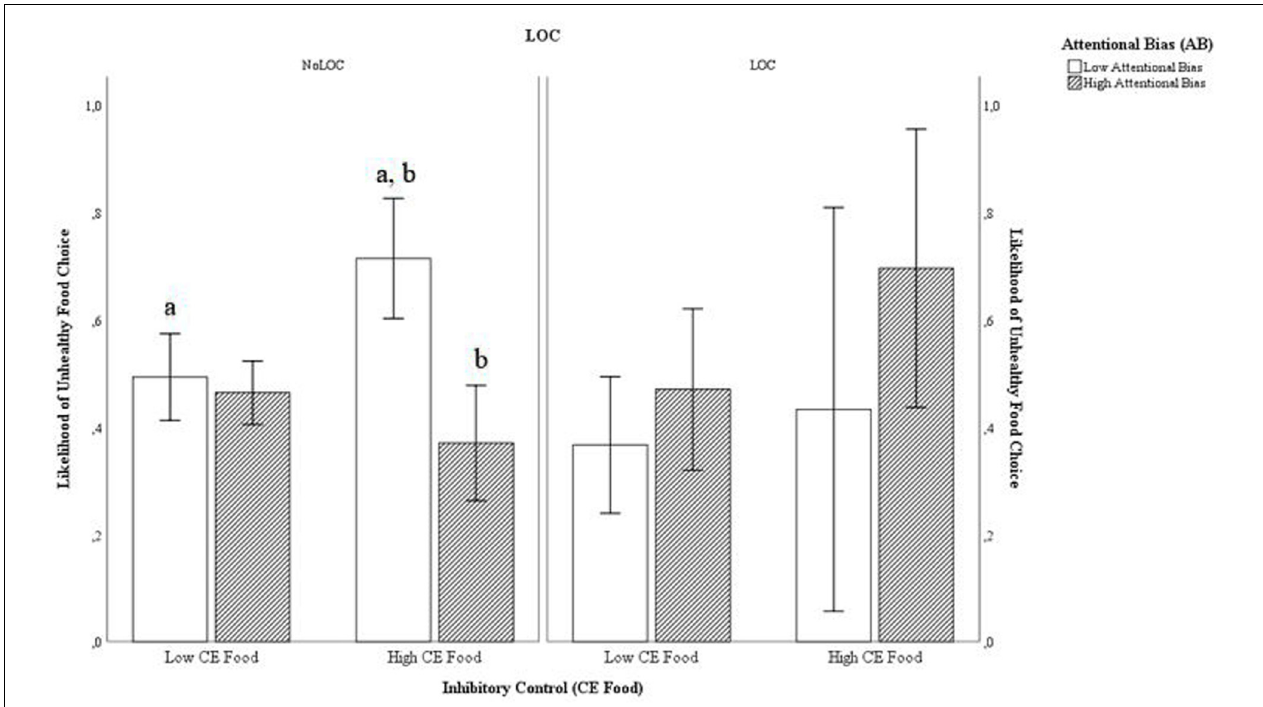
FIGURE 1 | Three-way interaction between inhibitory control (CE food ), attentional bias (AB), and LOC in predicting unhealthy food choice. CE food , Commission Errors on Food Pictures; AB, Attentional Bias Score; LOC, Loss of Control over Eating. a: t (29) = 3.46, p = 0.002**; b: t (22) = –4.49, p ≤ 0.001***. Error Bars: 95% confidence